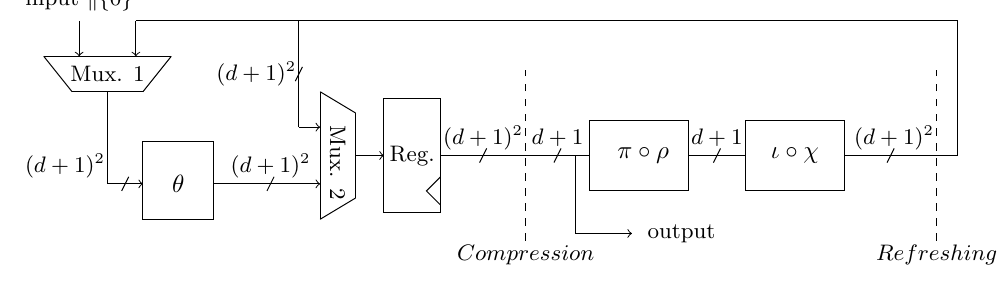
Figure 4: Our generic low-latency